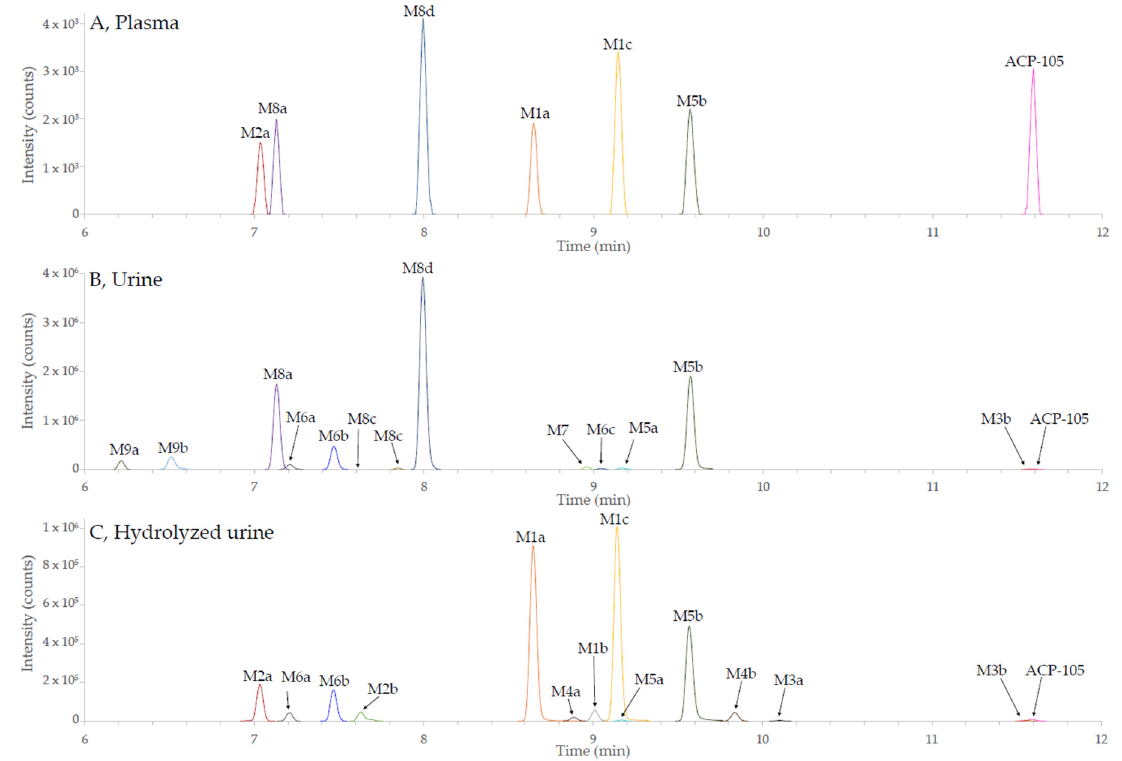
Figure 3. Combined extracted ion chromatograms of the metabolites of ACP-105 fulfilling the set criteria from the UHPLC- HRMS analysis. A full description of the metabolites and their denotations can be found in Table A1 in Appendix A. ( A ) metabolites in plasma 12 h after administration; ( B ) metabolites in urine 24 h after administration and; ( C ) metabolites in hydrolyzed urine 24 h after administration. The metabolite labels represent the following metabolic transformations: monohydroxylation (M1), dihydroxylation (M2), loss of 2H (M3), loss of 2H and monohydroxylation (M4), loss of 2H and dihydroxylation (M5), loss of 2H and trihydroxylation (M6), glucuronidation (M7), monohydroxylation and glucuronidation (M8) and dihydroxylation and glucuronidation